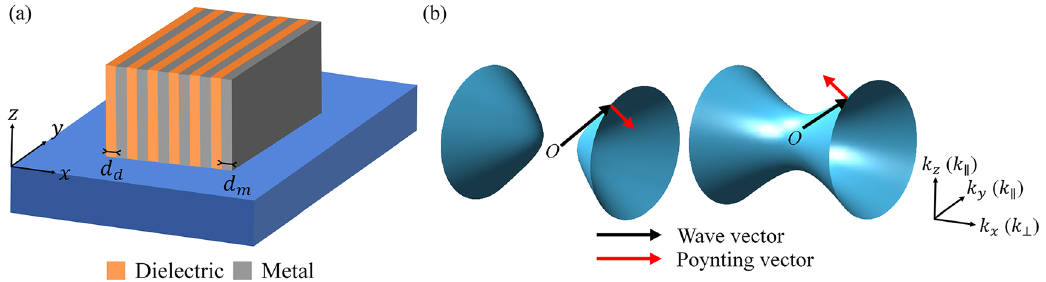
Figure 1: Characteristics of vHMM. (a)Schematicsofaverticallystackedhyperbolicmetamaterial(vHMM).The x -directionisperpendiculartothelayers.(b)Isofrequencysurfaces of a type-I HMM (left) and a type-II HMM (right). The vHMM is a type-II HMM. The wave vector and the Poynting vector of the type-II HMM have different signs along the x -direction; this characteristic implies that the vHMM can provide negative